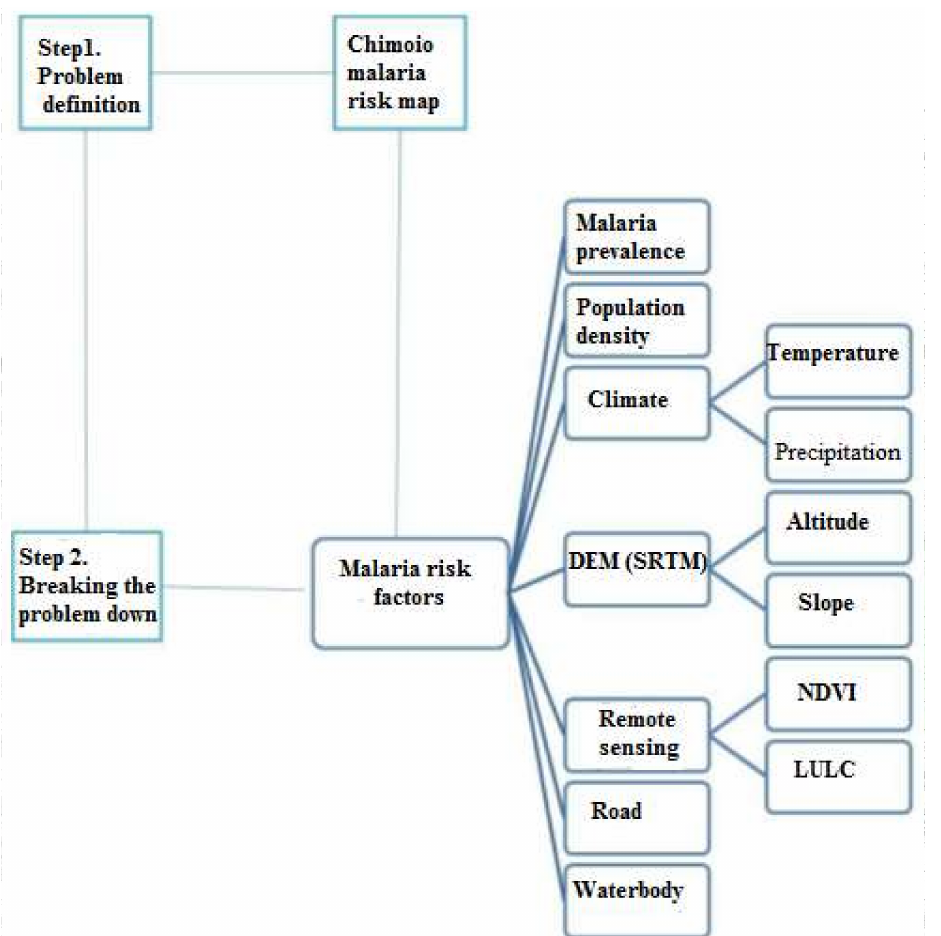
Figure 1. Schematic representation of the data flow and analysis for generating a malaria risk map for Chimoio. DEM/SRTM = Digital elevation model/Shuttle Radar Topography Mission, NDVI = Normalized digital difference index, LULC = Land use and land